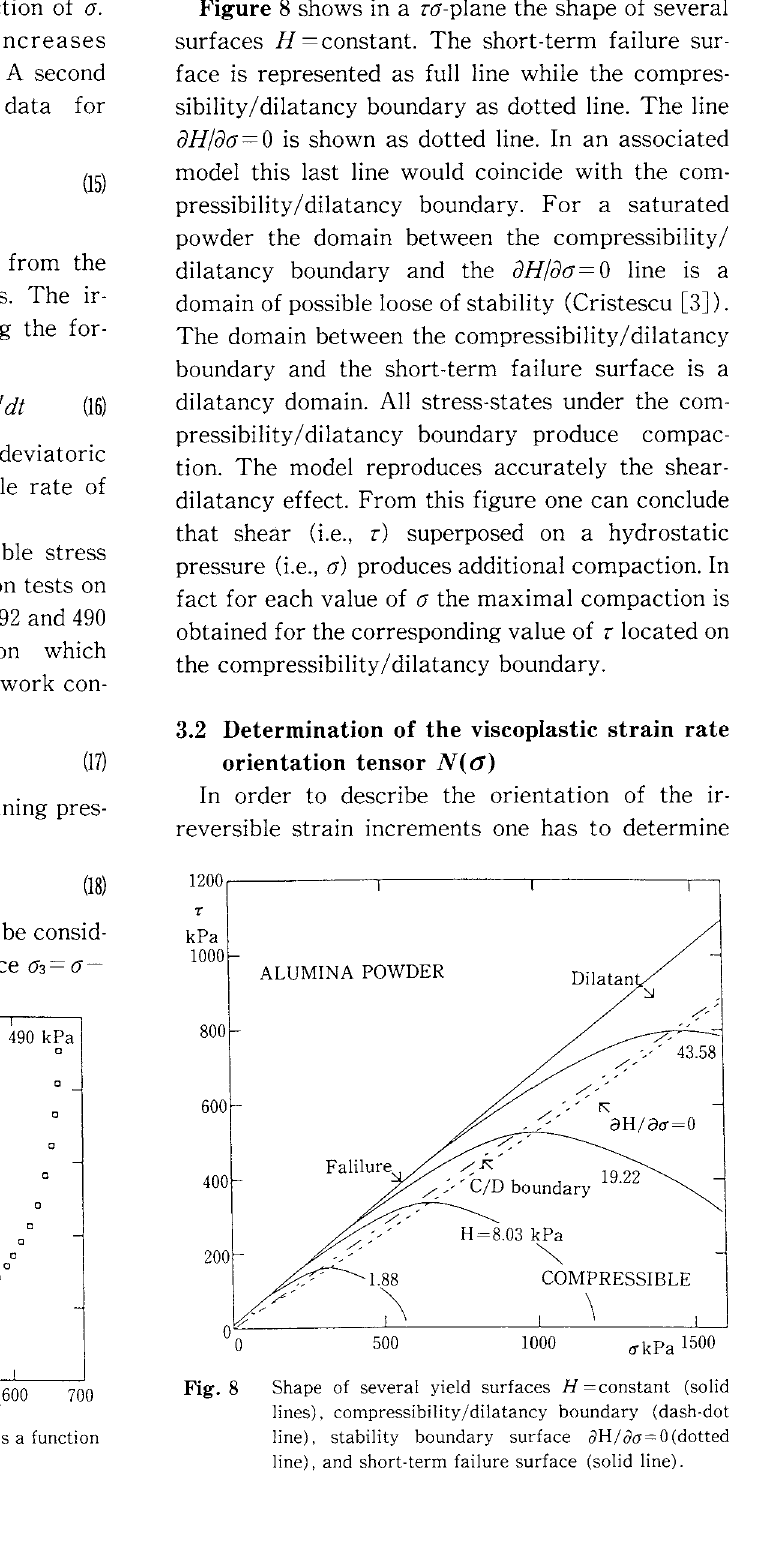
Variation of the irreversible stress work as a function of r for different confining pressures.